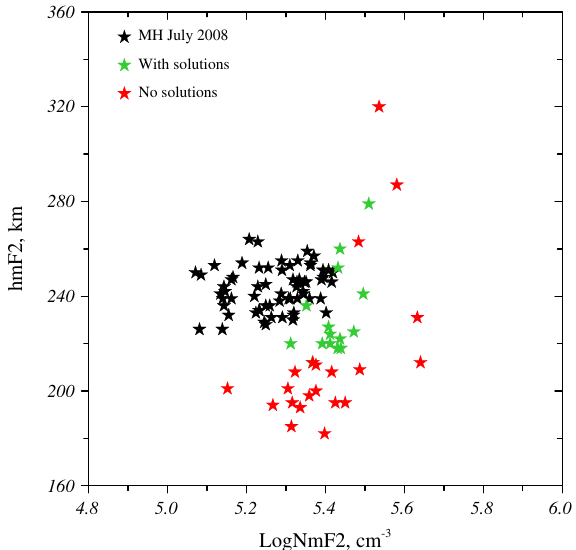
Fig. 6. Observed with COSMIC and Millstone Hill ISR EDP on January 31, 2008.